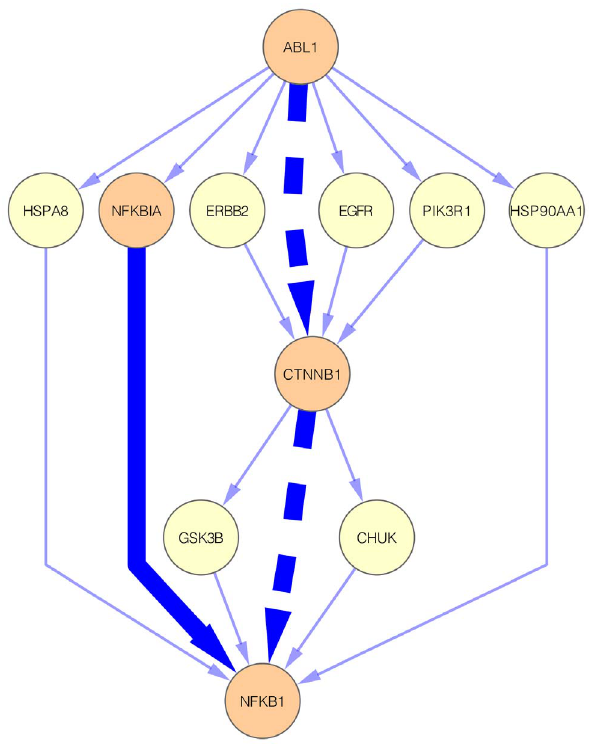
Figure 6. The ABL1 ? NFKB1 subnetwork. This subnetwork contains 18 interactions. The highlighted solid edge represents the interaction presents in the corresponding OLP. The highlighted dashed edges represent the interactions of the potential oncogenic pathway (ABL1 ? CTNNB1 ? NFKB1). Blue edges represent protein physical interactions and orange nodes represent genes participating in the known or potential oncogenic pathways.